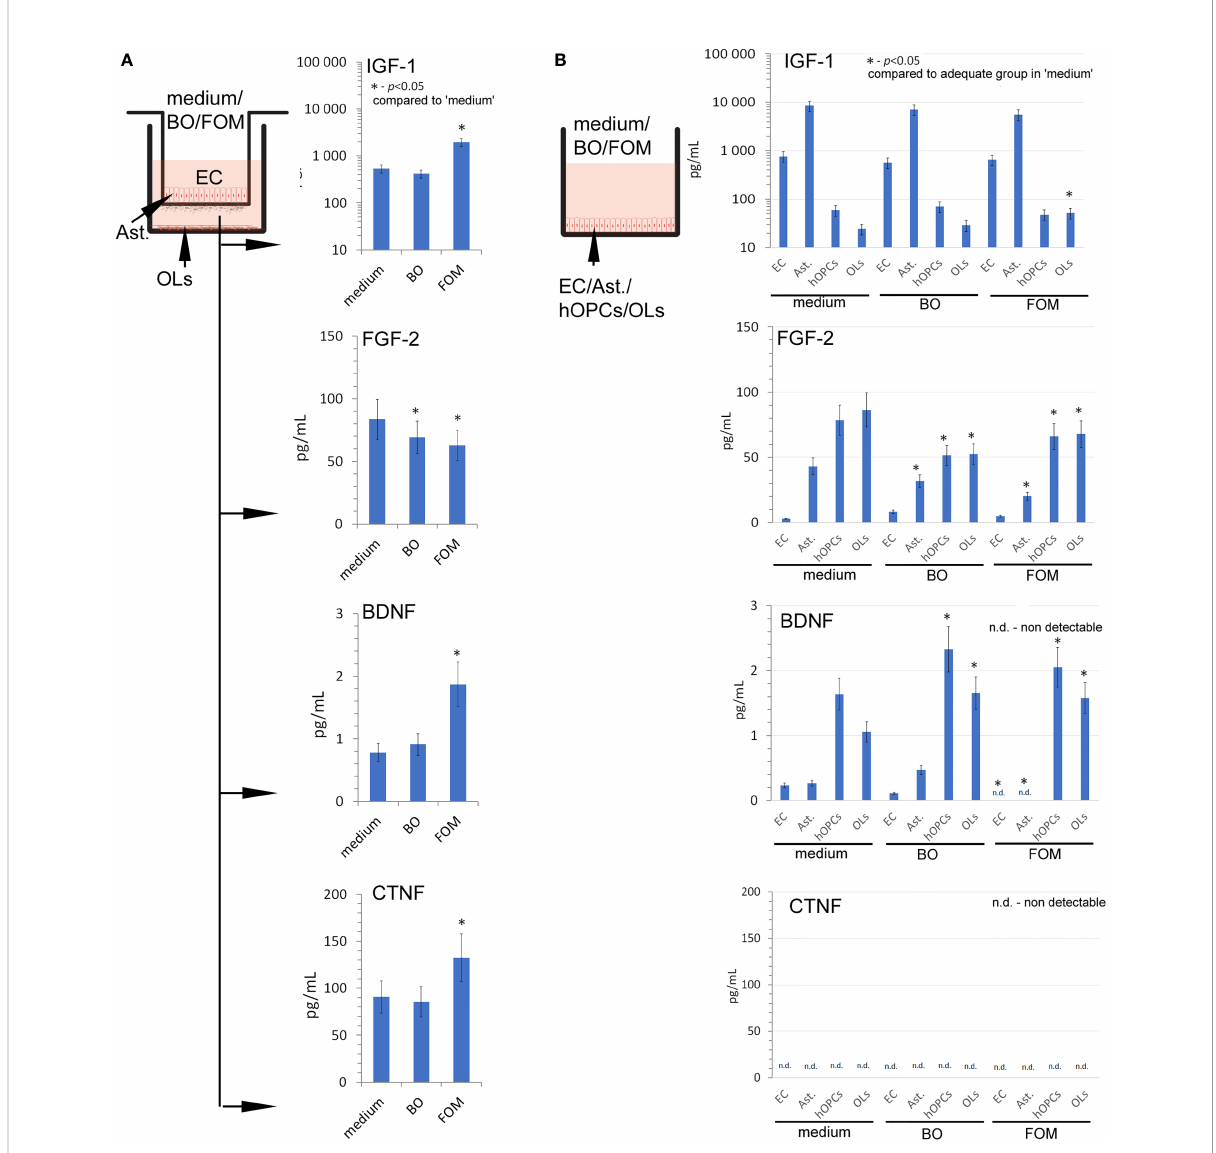
FIGURE 3 The supplementation of BBB cells by FOM during polarization of hOPCs to mature OLs resulted in the stimulation of IGF-1, BDNF, and CNTF but decreased FGF-2 synthesis. (A) The concentration of IGF-1, BDNF, CNTF, and FGF-2 in supernatants of the BBB construct with OLs. BBB cells were conditioned by FOM or BO. (B) The analysis of FOM and BO effect on individual cell subpopulations: endothelial cells, astrocytes, hOPCs, and OLs. The graph presented the means ± SD from three independent experiments. The differences between BO and FOM supplementation vs . adequate group in medium were calculated using the paired